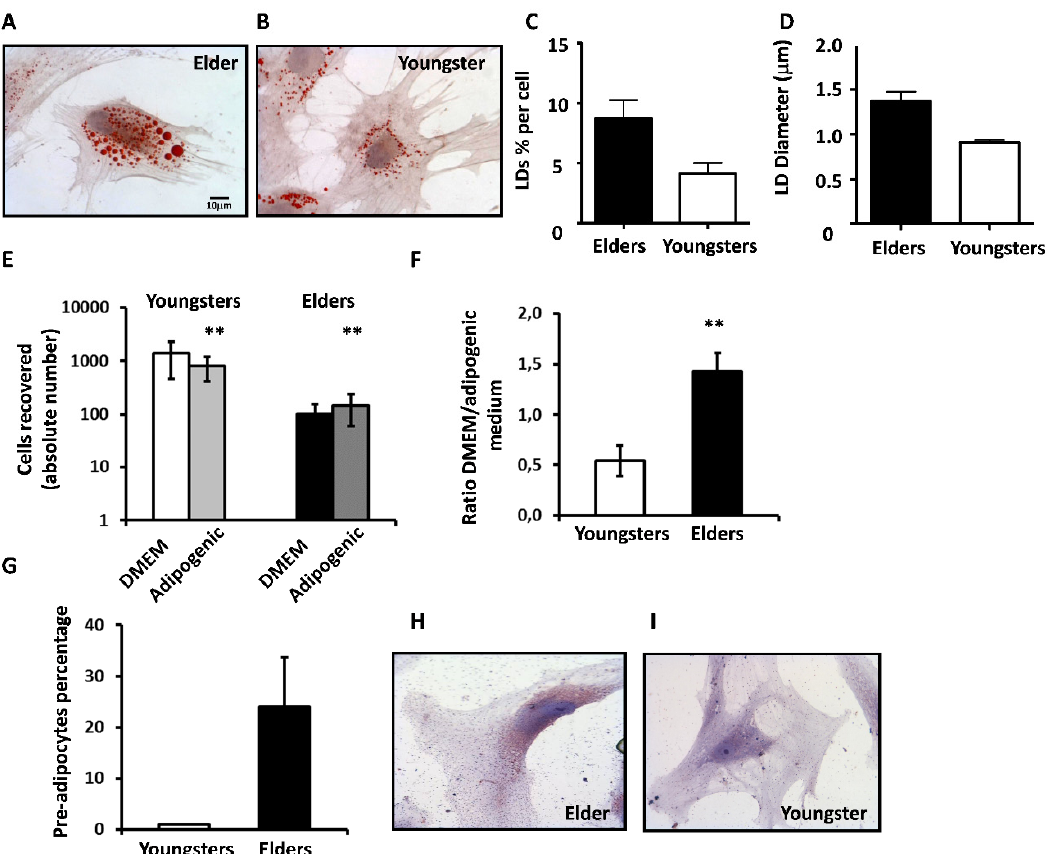
Figure 7. BM-MSCs of elders are prone to adipocyte differentiation. ( A , B ). Representative red oil staining of elder ( A ) and young ( B ) BM-MSCs cultured in AM on Day 9. ( C ). Mean values ± SD of the percentage of lipid drops (LDs) content per cell in young (white) and elder (black column) BM-MSCs. ( D ). Mean values ± SD of the LD diameter ( µ m) in young (white) and elder (black column) BM-MSCs. ( E ). Absolute number of cells recovered from young and elder BM-MSCs, cloned by limiting dilution in DMEM or AM. ( F ). Ratio between the number of recovered cells from both young and elder BM-MSCs grown in AM or in DMEM. ( G ). Percentage of young or elder positive clones stained with red oil. ( H , I ). Representative red oil re-staining of all DMEM plates of elder ( H ) and young ( I ) BM-MSCs. In all panels, data are expressed as mean ± SD, ** p < 0.01.